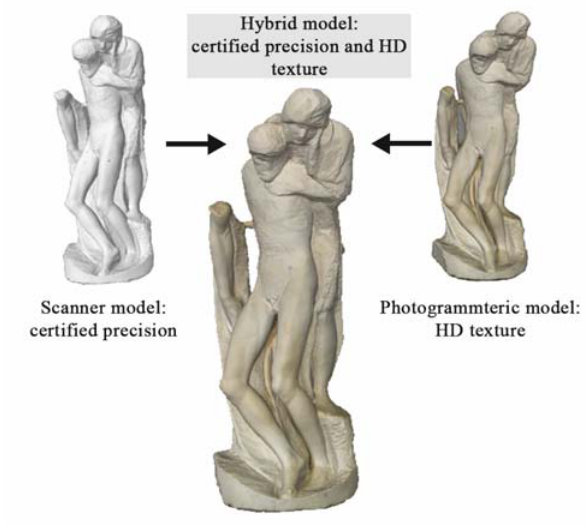
Figure 12. The final hybrid model in the 1:1 rendering scale.